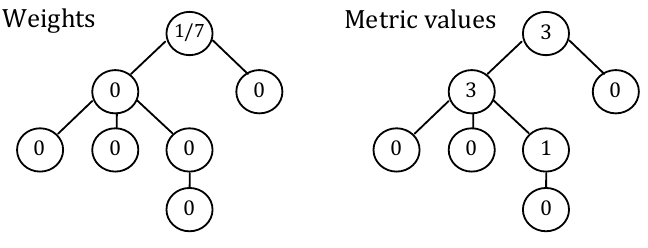
Fig 9. Calculation of the “size of the largest family as percentage of the words”. In this example the result is 0x1+0x3+0x1+0x1